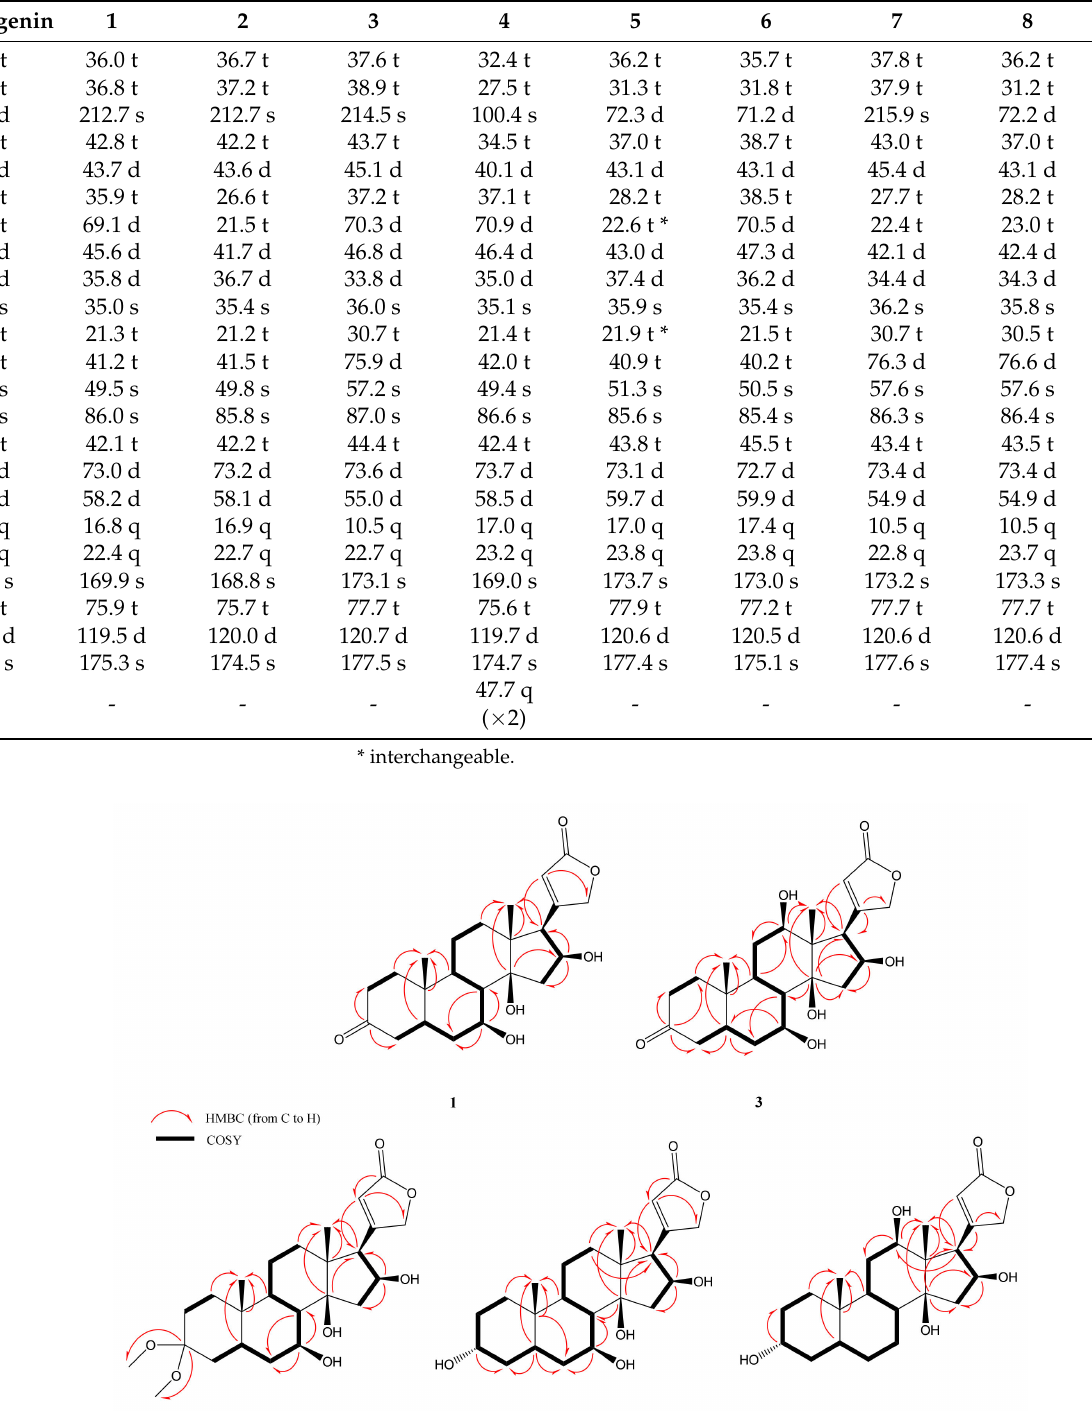
Table 2. 13 C-NMR data of gitoxigenin and compounds 1 – 8 δ C (ppm).